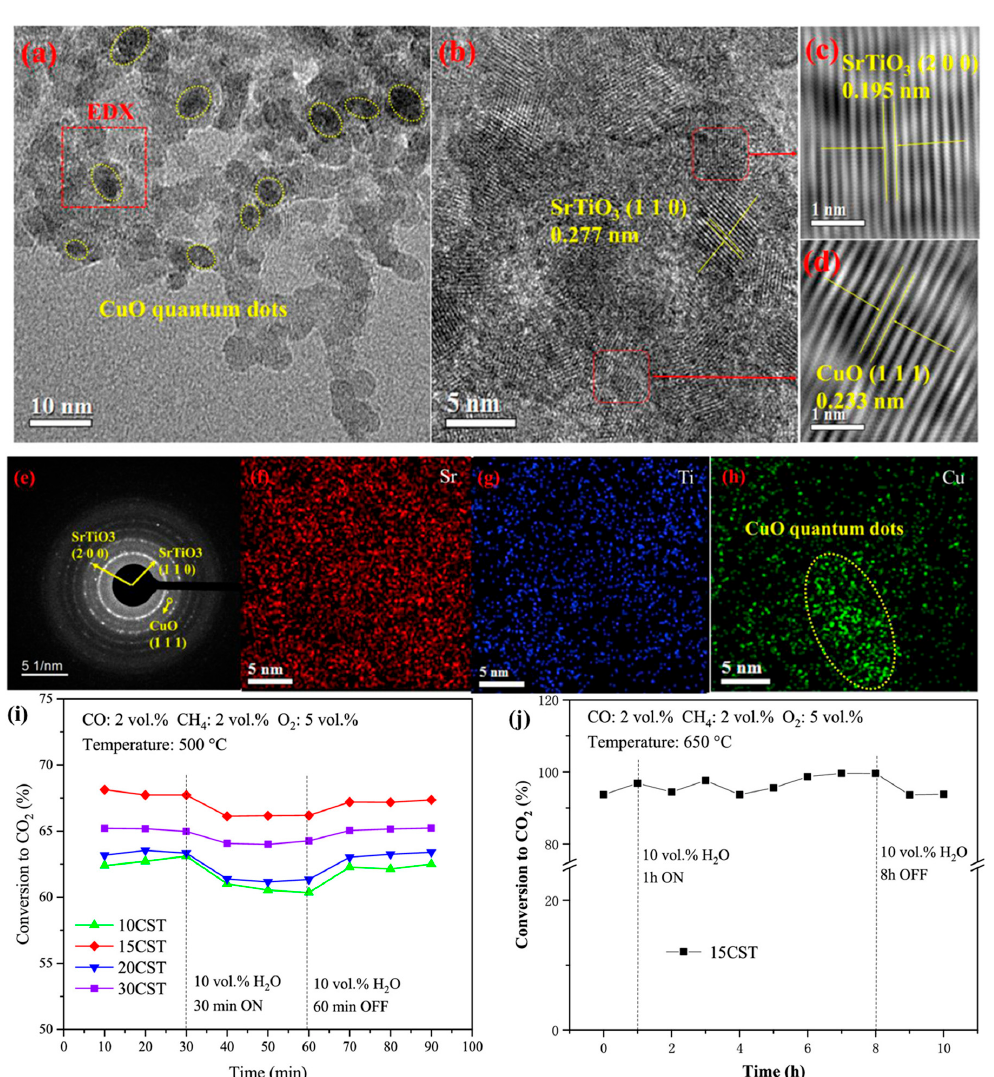
Figure 8. TEM analysis of the 15 wt% CuO/SrTiO 3 catalysts: HRTEM micrographs ( a , b ); inverse fast Fourier transform images ( c , d ); SAED patterns ( e ); and elemental mapping ( f - h ); time on stream and in the presence of 10% H 2 O: four CuO-SrTiO 3 catalysts ( i ) and 15 wt% CuO/SrTiO 3 ( j ). Reprinted with permission from Ref. [77]. Copyright 2021, copyright American Chemical Society.